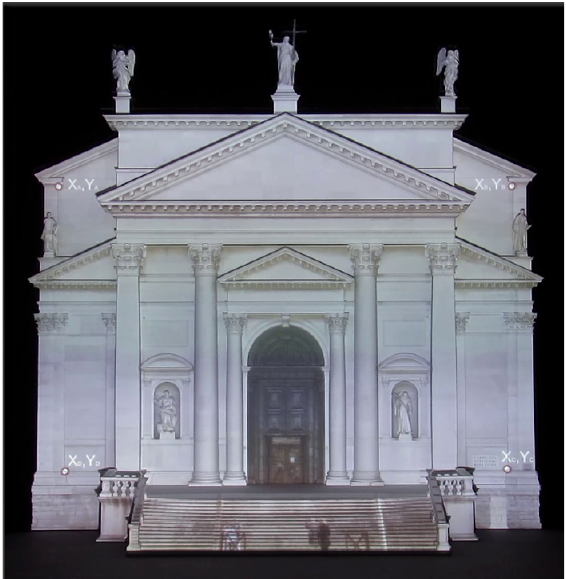
Figure 3. The image after the automatic